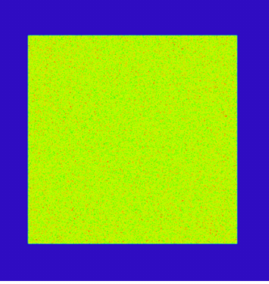
Figure 7. Light spot at the exit end of the homogenizing pipe.